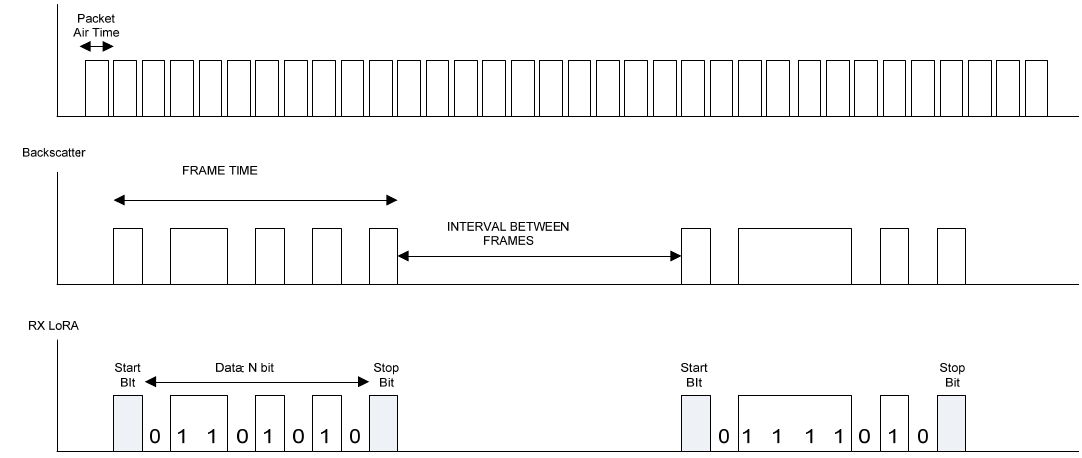
Figure 5. Block diagram showing the data transmission using the reflection of the transmitted packets.